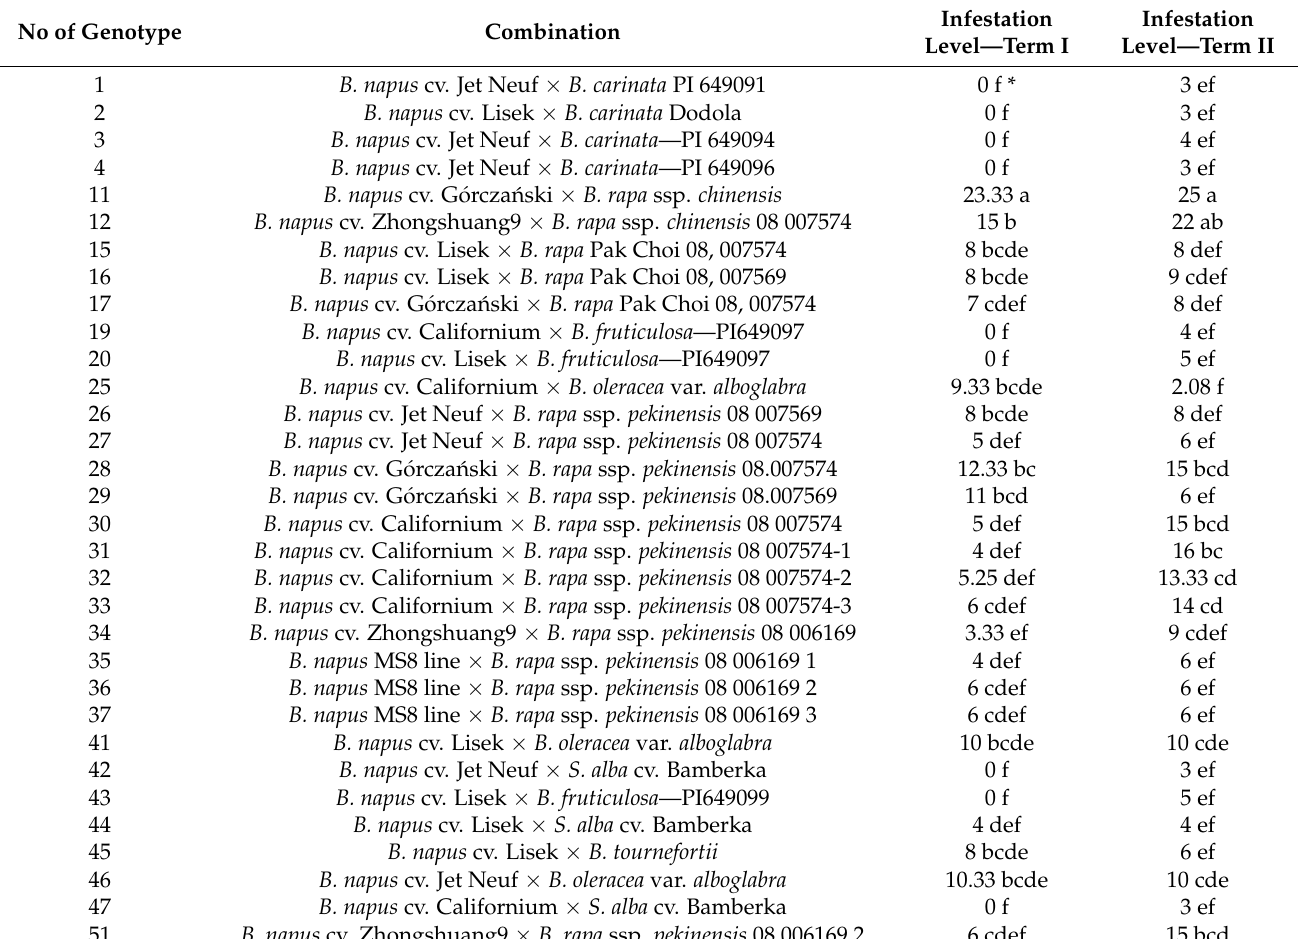
Table 5. Results of blackleg field resistance assessment for hybrid plants. The level of infestation is expressed as a percentage.